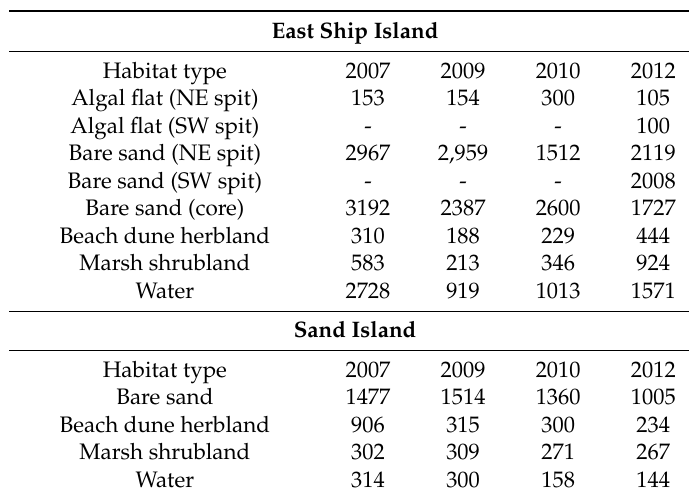
Table 1. Number of training pixels used in